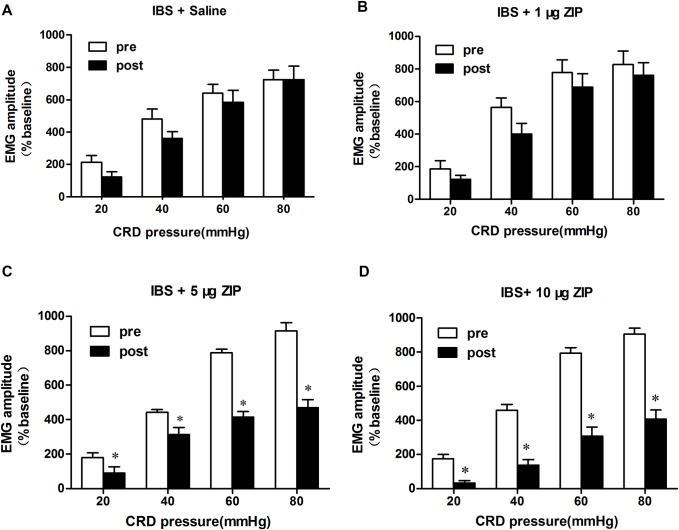
Inhibitory effect of intrathecal ZIP injection on EMG response in IBS-like rats.A: EMG amplitude at 20–80 mmHg CRD pressure after saline in IBS-like rats. B: EMG amplitude at 20–80 mmHg CRD pressure after 1 μg ZIP in IBS-like rats. C: EMG amplitude at 20–80 mmHg CRD pressure after 5 μg ZIP in IBS-like rats. D: EMG amplitude at 20–80 mmHg CRD pressure after 10 μg ZIP in IBS-like rats. ZIP dose-dependently inhibited the chronic visceral hypersensitivity in IBS-like rats; n = 10, respectively. *p < 0.05 vs. pre-drug. EMG: electromyography; CRD: colorectal distention; IBS: irritable bowel syndrome; ZIP: PKMζ inhibitor.